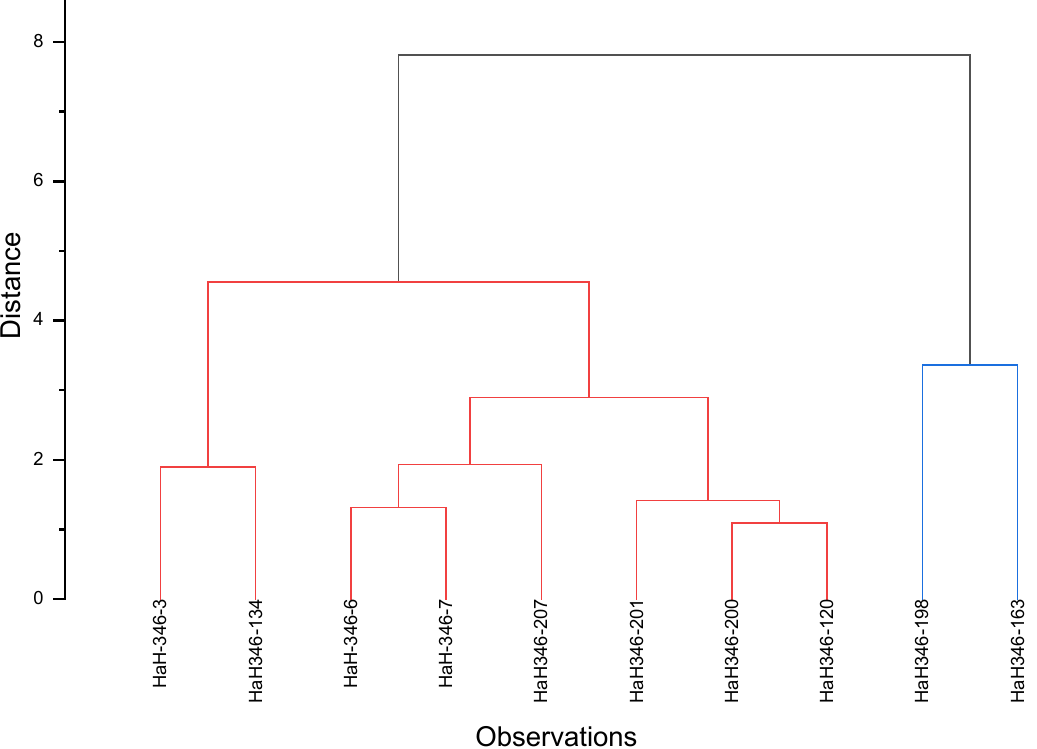
22 Na, 26 Al, 40 K, 54 Mn, and 60 Co